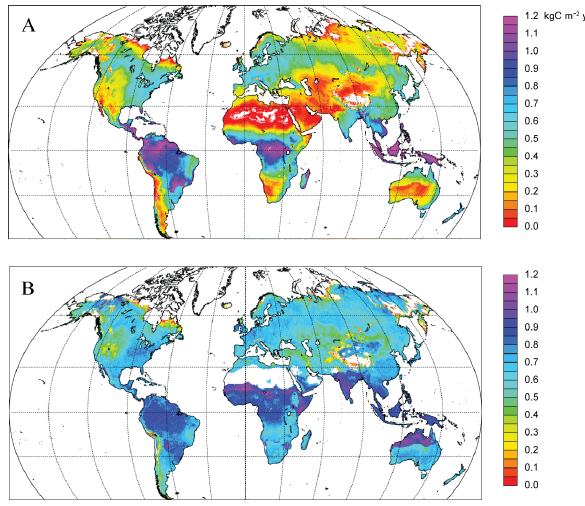
Fig. 1. (A) Mean annual NPP (kgCm − 2 yr − 1 ) for 1961–1990 sim- ulated by the C–N version of LPJ-GUESS in the global hindcast experiment; (B) N limitation of NPP, showing the value obtained by dividing mean NPP in each grid cell for 1961–1990 from the C–N simulation by the value obtained in a C-only simulation with the same value of the global quantum efficiency scalar α a (see text). Values close to 1 thus denote “no limitation”, lower values increas- ing limitation of NPP by N availability.